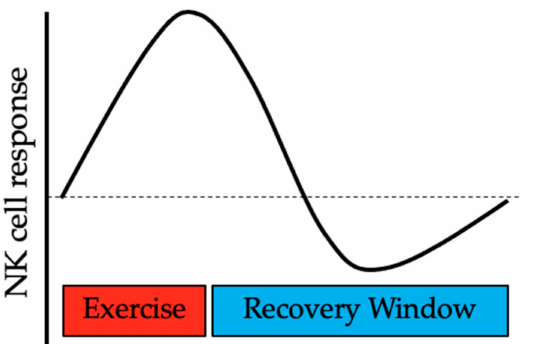
Figure 1. Biphasic response to exercise that results in an increase in NK counts immediately post- exercise followed by cellular egress below resting